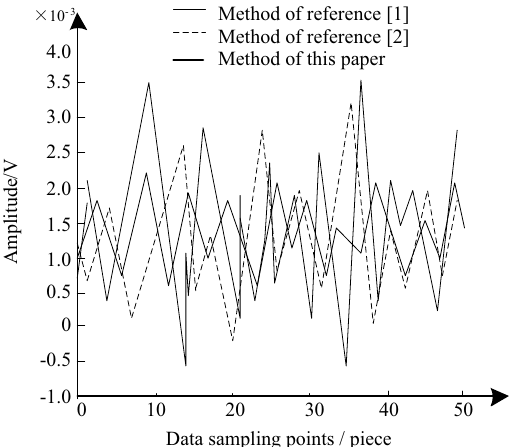
Figure 3: The output amplitude comparison results of music teaching and ideological and political integration resources in colleges and